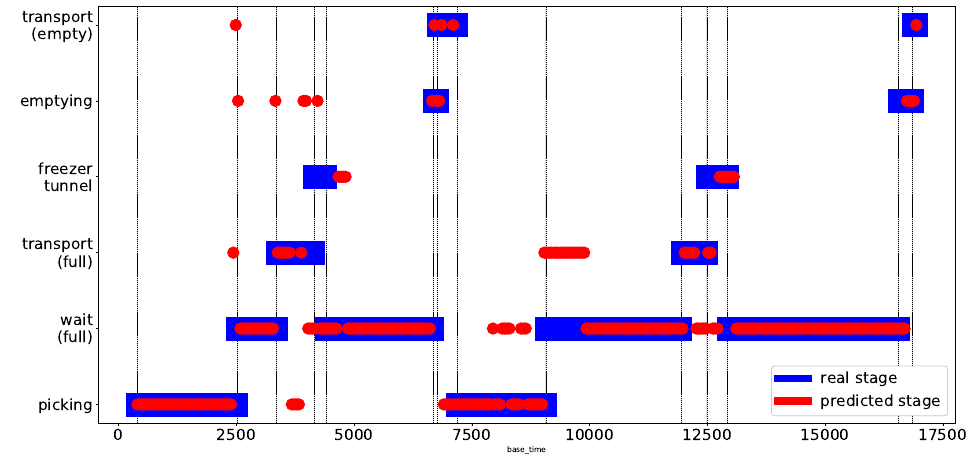
Figure 9. This graph shows a comparison between the stages estimated by the KNN classifier (red circles) and the real stages of the harvest associated with Node 3 (blue